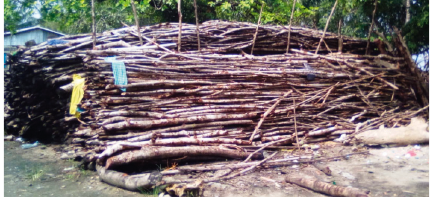
Figure 11: Mangrove wood piles for fish drying at Dahomey